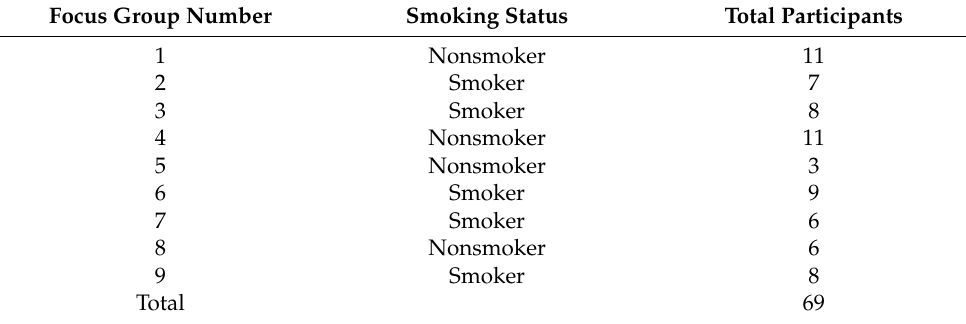
Table 2. Description of focus groups by smoking